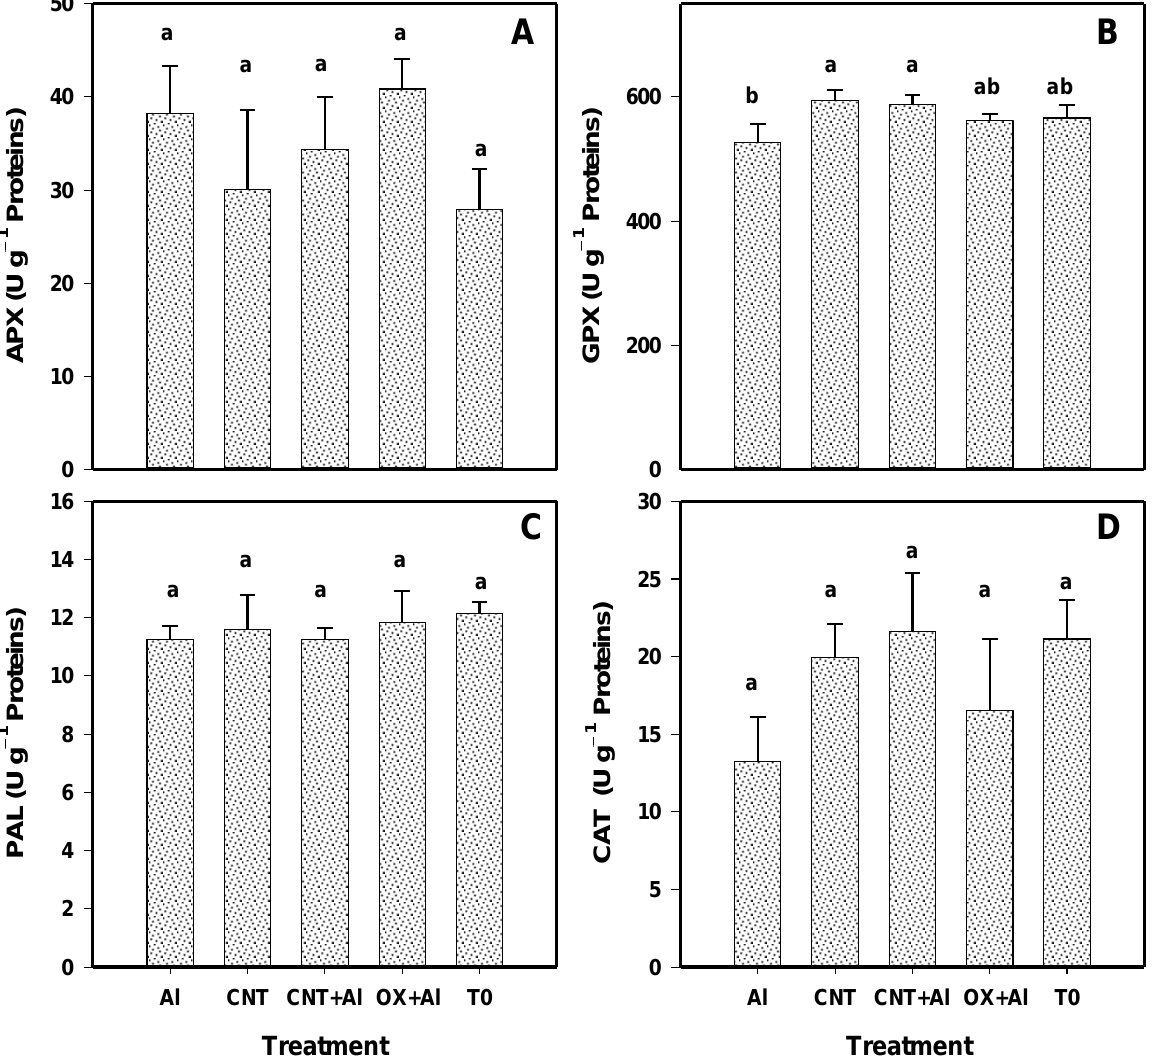
Figure 6. Enzymatic activity of ascorbate peroxidase (APX) ( A ), glutathione peroxidase (GPX) ( B ), phenylalanine ammonia lyase (PAL) ( C ), and catalase (CAT) ( D ) in leaves of tomato plants. Al: Positive control inoculated with A. solani ; CNT: Carbon nanotubes; OX: Commercial control; T0: Control. Different letters indicate significant differences between treatments according to the least significant difference of Fisher test (α = 0.05). N = 5 ± standard error.